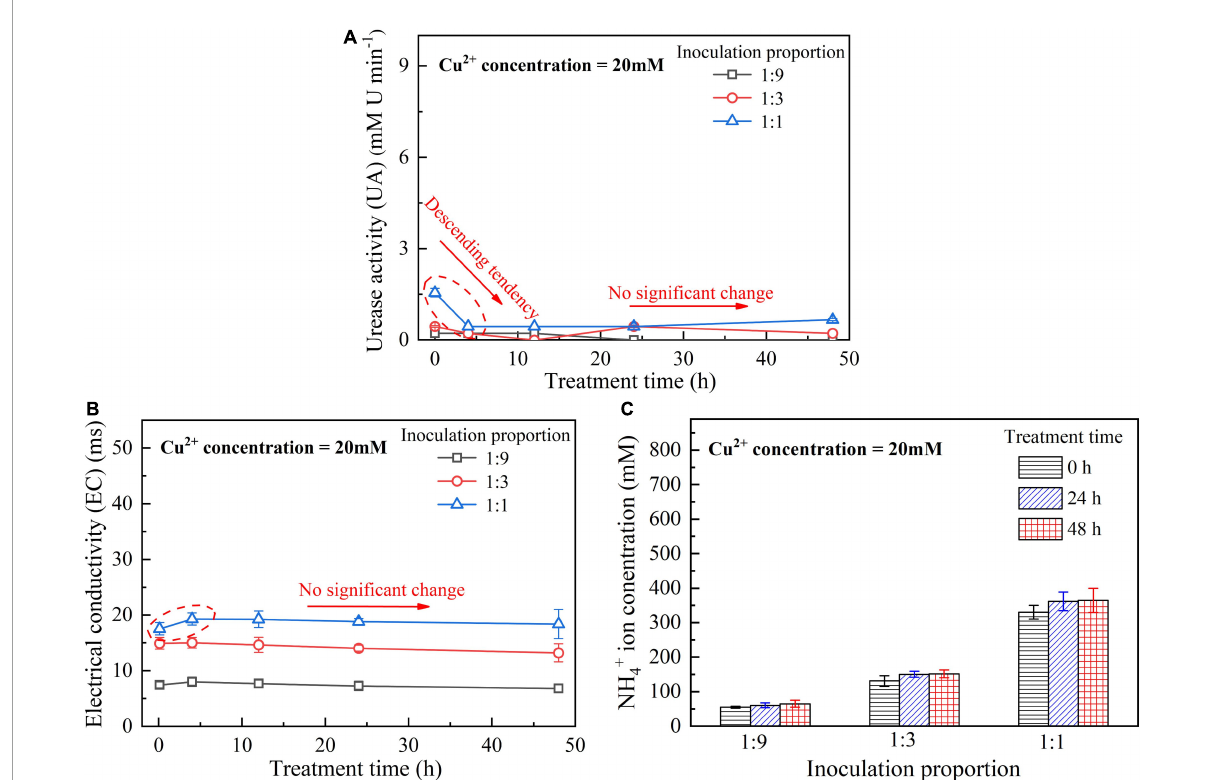
FIGURE1 (A) UA vs. treatment time relationship, (B) EC vs. treatment time relationship, and (C) NH 4 + vs. treatment time relationship when subjected to Cu 2 + concentration at 20